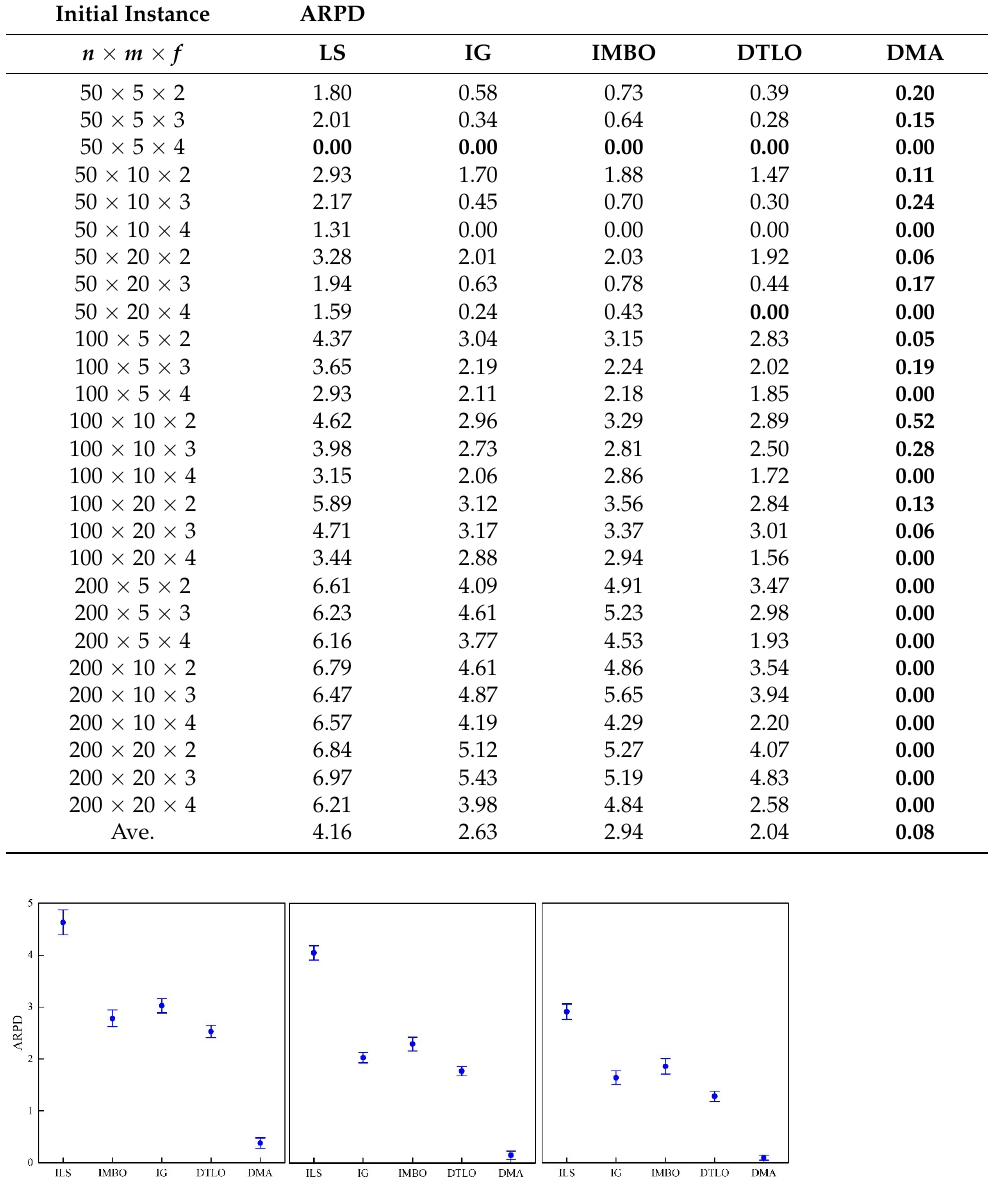
Table 6. Comparison results of different algorithms by β = 3.